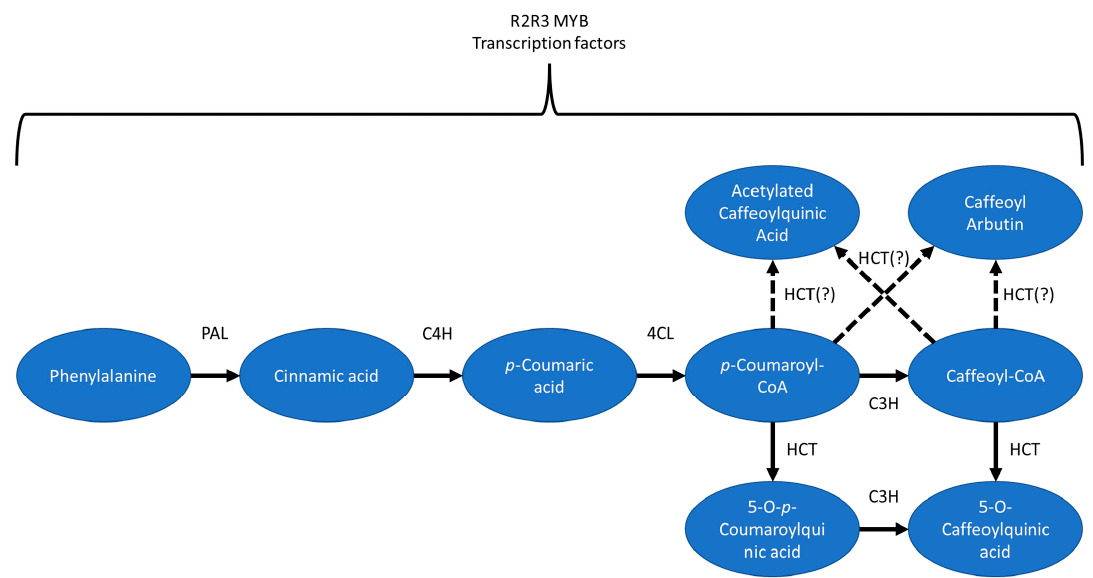
Figure 6. Some of phenolic acid biosynthesis pathways. Solid lines with arrows represent known relationships while dashed lines with arrows represent possible biosynthesis pathways based on the mapping data. Enzymes: phenylalanine ammonia lyase (PAL), cinnamate 4 (cid:48) -hydroxylase (C4H), 4-cinnamoyl CoA ligase (4CL), hydroxycinnamoyl CoA: quinate hydroxycinnamoyl transferase (HCT), and p-coumaroyl-3 (cid:48) -hydroxylase (C3H). Various R2R3 MYB transcription factors are believed to play regulatory roles in the various biosynthesis